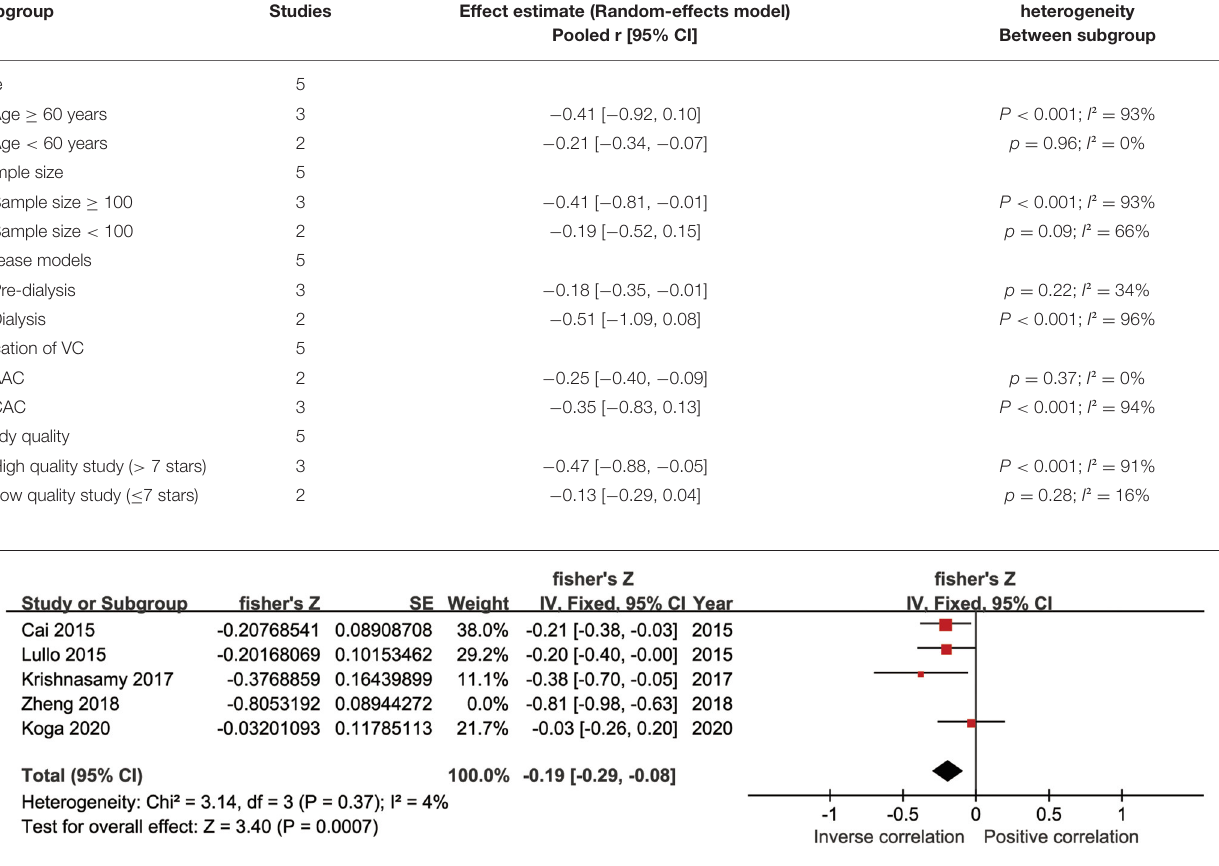
FIGURE 3 | Forest plots of the summary r after removing Zheng’s